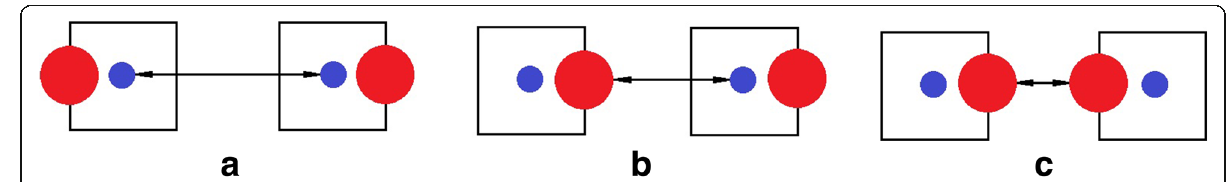
Fig. 10 Reducing of R perc for interaction between different defects ( a - c ) in comparison with a uniform distribution of Fe ( blue ) atoms is caused by the presence of oxygen vacancies V(O) ( red